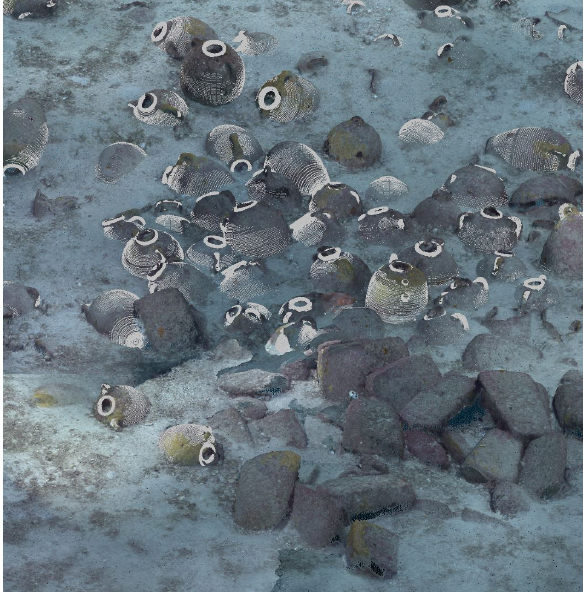
Figure 5. Xlendi 2014 survey represented with over one hundred million points. The recalculated artifacts are represented with a lower density of